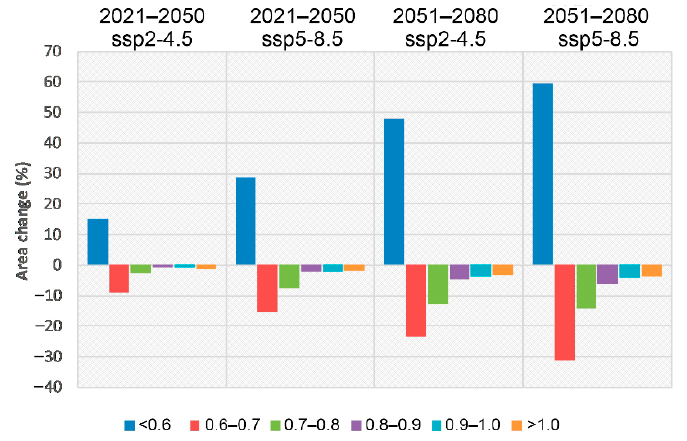
Figure 4. Change in areas (in %) of the Sevastopol region with different HTC values for two future periods under different SSPs relative to the base period (1981–2014).